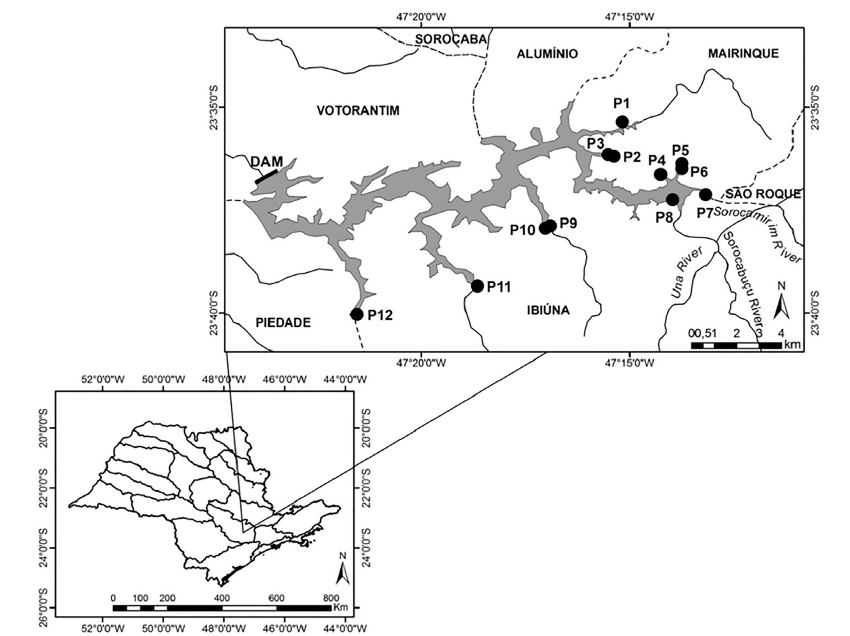
Figure 1. Location of Itupararanga Reservoir in Sorocaba watershed (São Paulo State) with sampling sites represented by black